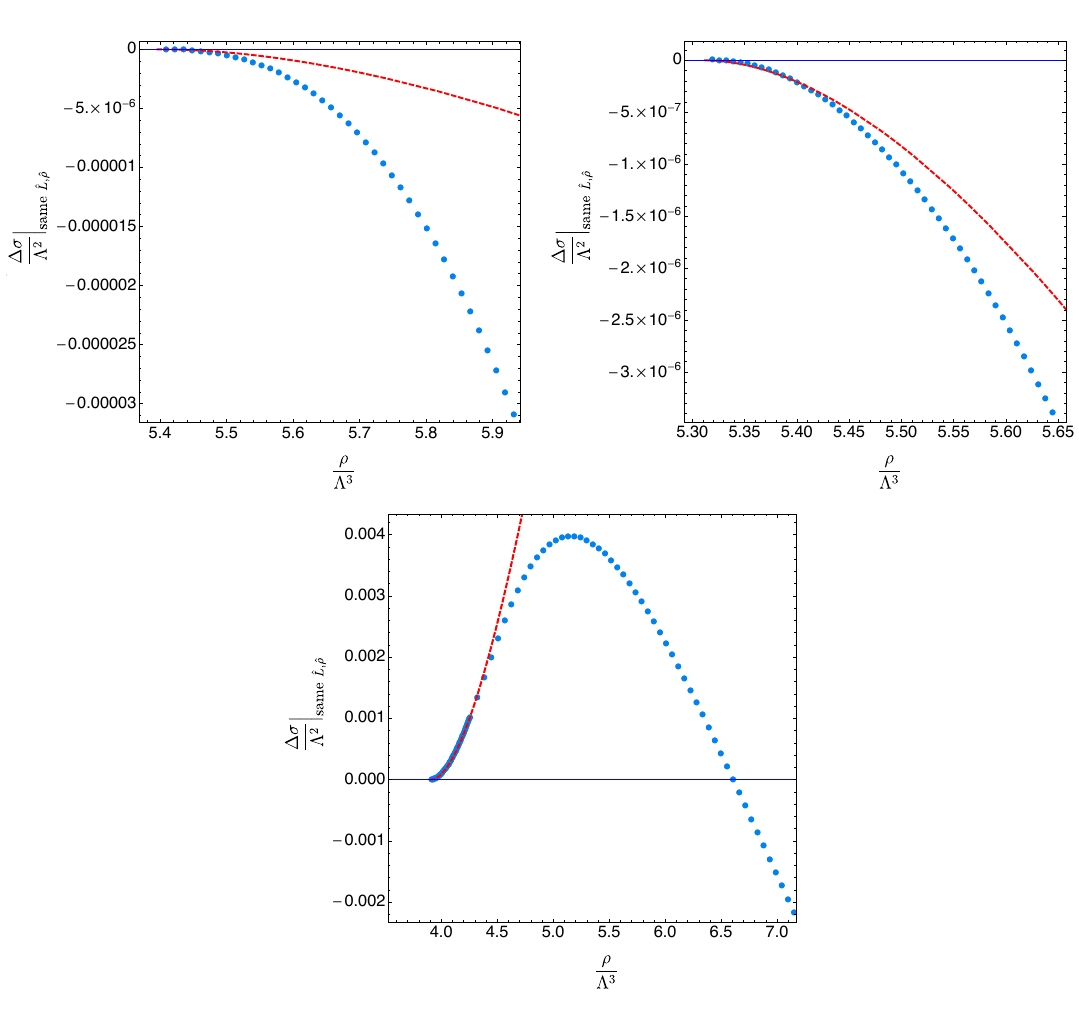
(cid:12) Figure 14 . Difference ∆ˆ σ between the Killing entropy densities of lumpy and uniform (cid:12) sameˆ L, ˆ ρ branes with the same (ˆ L, ˆ ρ ) as a function of the Killing energy density ˆ ρ for three constant- ˆ T families of lumpy branes with ˆ T ’ 0 . 390711 < ˆ T Σ (top-left), ˆ T ’ 0 . 405141 > ˆ T Σ (top-right) and 1 2 ˆ T ˆ T ’ 0 . 399547 < ˆ T ˆ T ˆ T Σ 1 < Σ 2 (bottom). Recall that Σ 1 ’ 0 . 390817 and Σ 2 ’ 0 . 404645 . The blue dots are the numerical results for the lumpy branes. The dashed, red curves are the perturbative result (2.72). The horizontal blue line indicates the uniform-brane